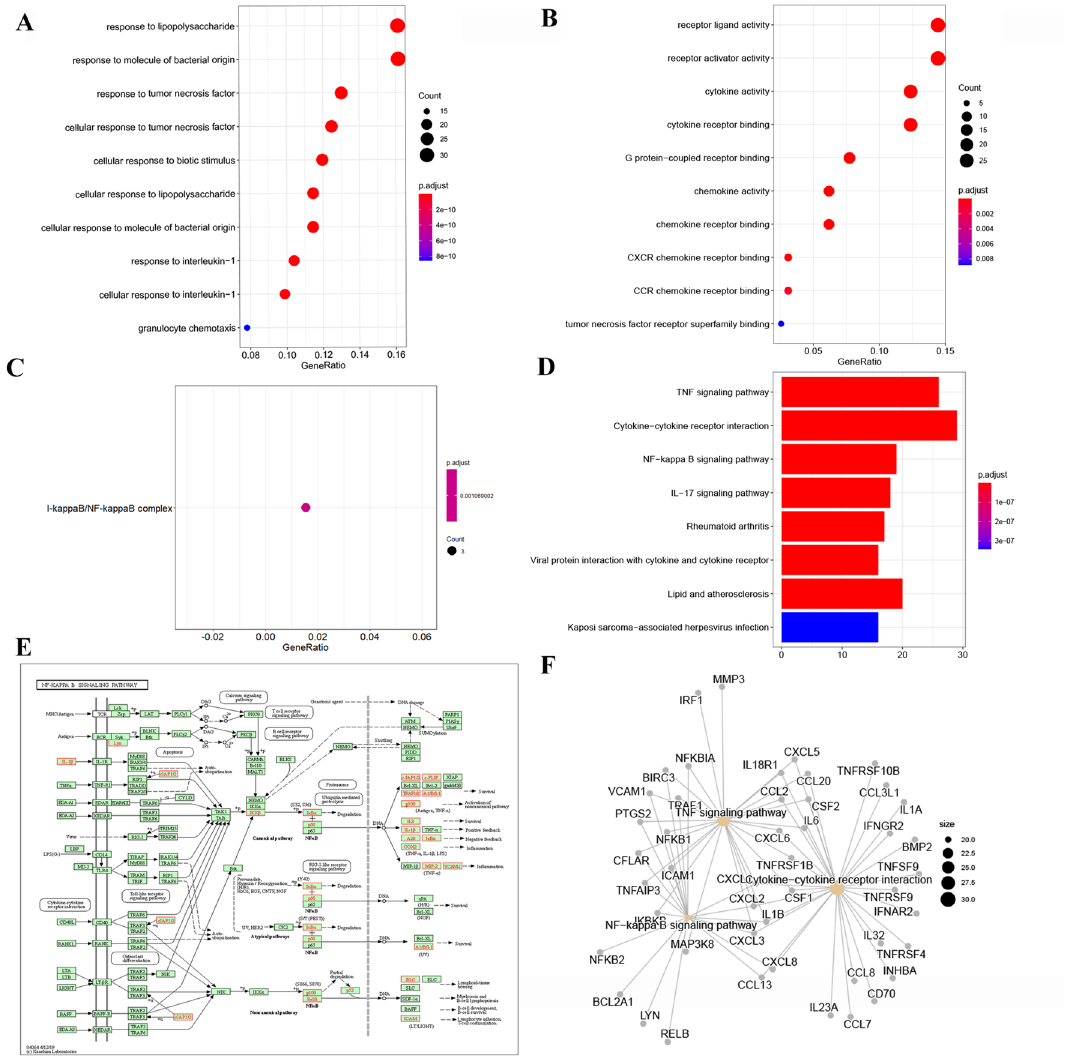
Figure 3. GO and KEGG pathway analysis of mRNAs in SFMSCs after IL-1β stimulation for 2 h. ( A – C ) GO annotations of upregulated mRNAs with the top 10 enriched genes/ratios of biological processes ( A ), molecular functions ( B ), and cellular components ( C ). P value cut off = 0.05, q-value cut off = 0.05. ( D ) KEGG pathway enrichment analysis of upregulated mRNAs with the top 10 most significant terms. ( E ) KEGG pathway annotations of NF-κB pathway. Genes in red are upregulated; those in black represent no significance. The KEGG map (map 04064) was developed by Kanehisa Laboratories ( F ) Genes involved in the top three significant pathways and interaction among the associated genes. Genesymbol was used to label the genes in image ( F ). Analysis was performed using R Software created by R Core Team (2021). R: A language and environment for statistical computing. R Foundation for Statistical Computing, Vienna, Austria. https:// www.R- proje ct.